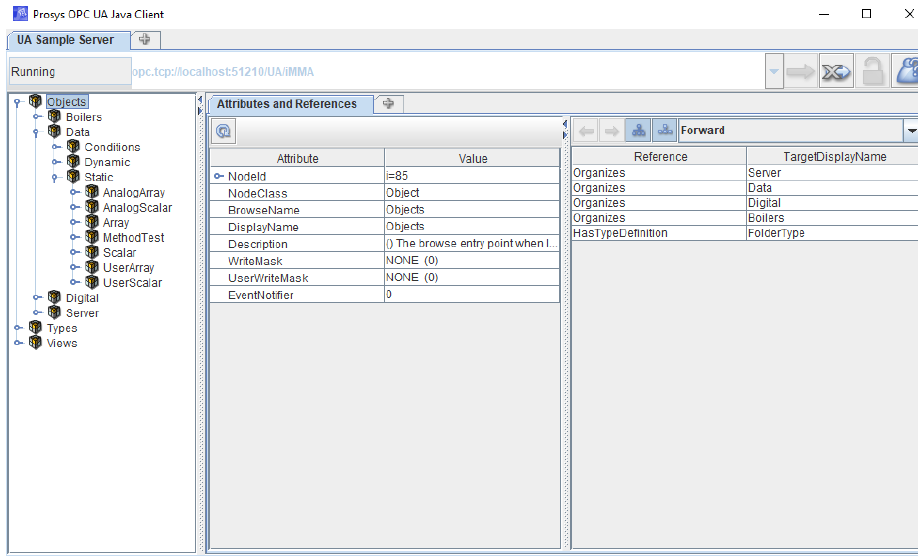
Figure 8. A screenshot of the Prosys OPC UA client accessing the information model of OPC UA. Scenario 2: In this case, the OPC UA server was also started before the industrial devices.